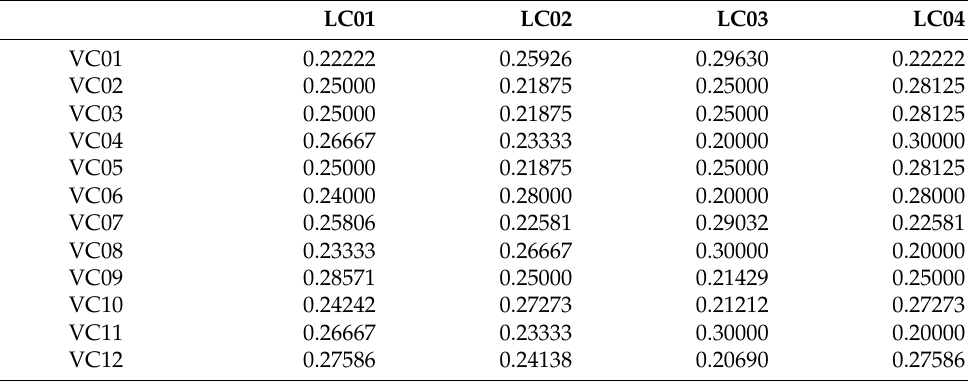
Table 3. Normalize matrix of the TODIM model.